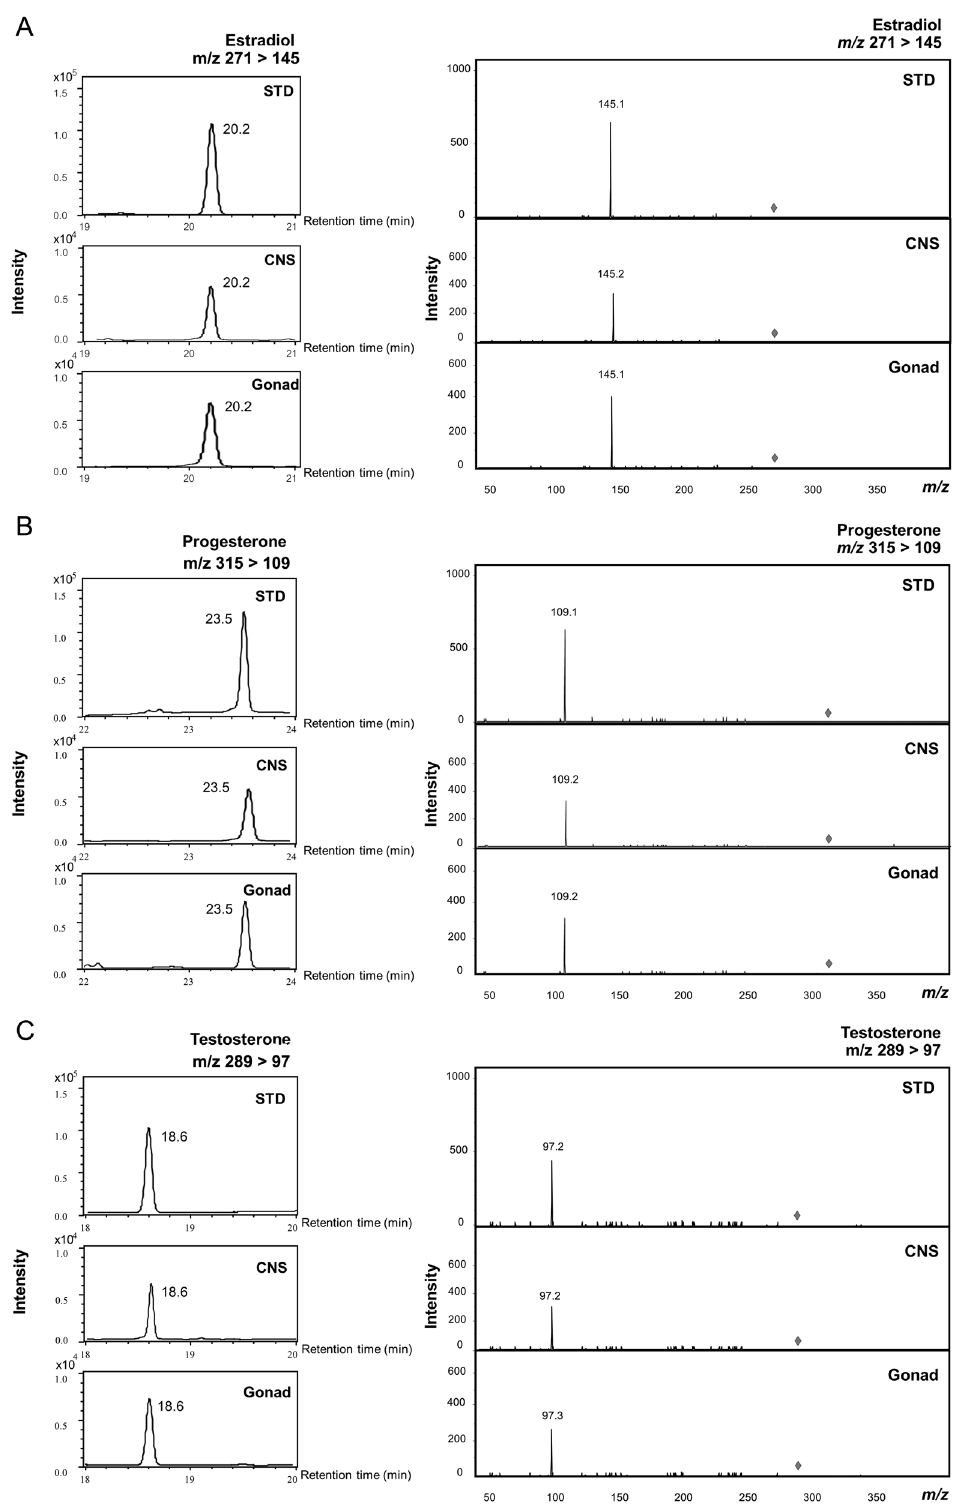
Figure 1. Chromatograms and mass spectra corresponding to the LC–MS/MS analysis of estradiol, progesterone, and testosterone isolated from CNS and gonad tissue of H. scabra. ( A ) Representative chromatogram and MRM spectra for estradiol transitions m/z 271 → 145. ( B ) Representative chromatogram and MRM spectra for progesterone transitions m/z 315 → 109. ( C ) Representative chromatogram and MRM spectra for testosterone transitions m/z 289 → 97. STD; standard, CNS; central nervous